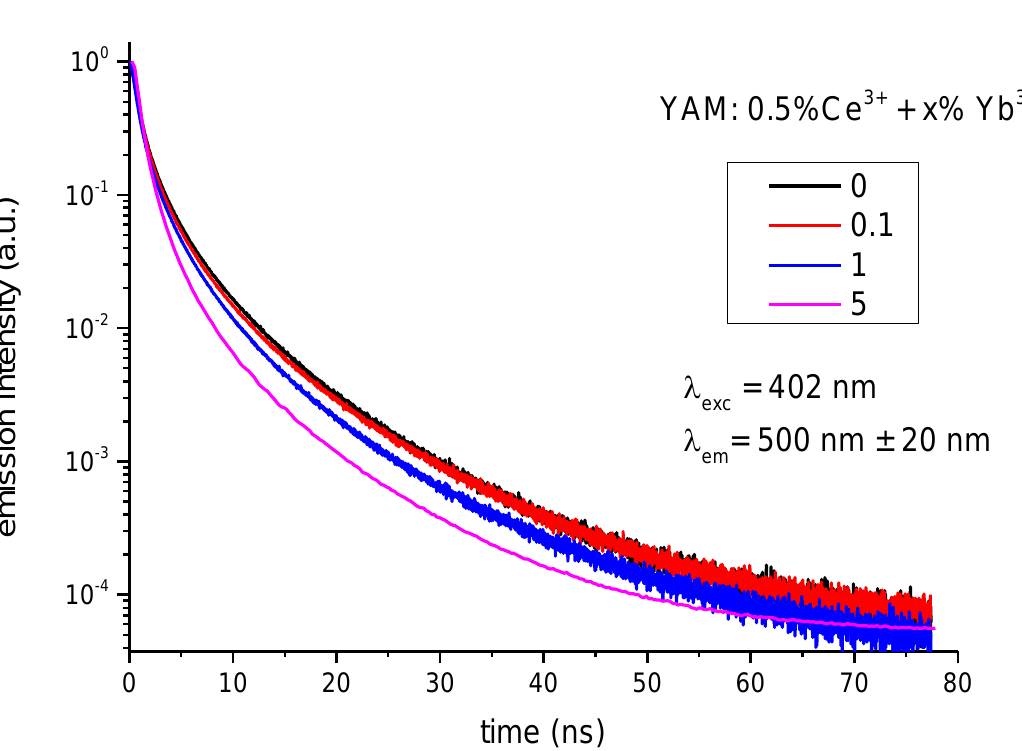
Figure 8. Luminescence decay profiles for samples with varying Yb 3+ concentration.